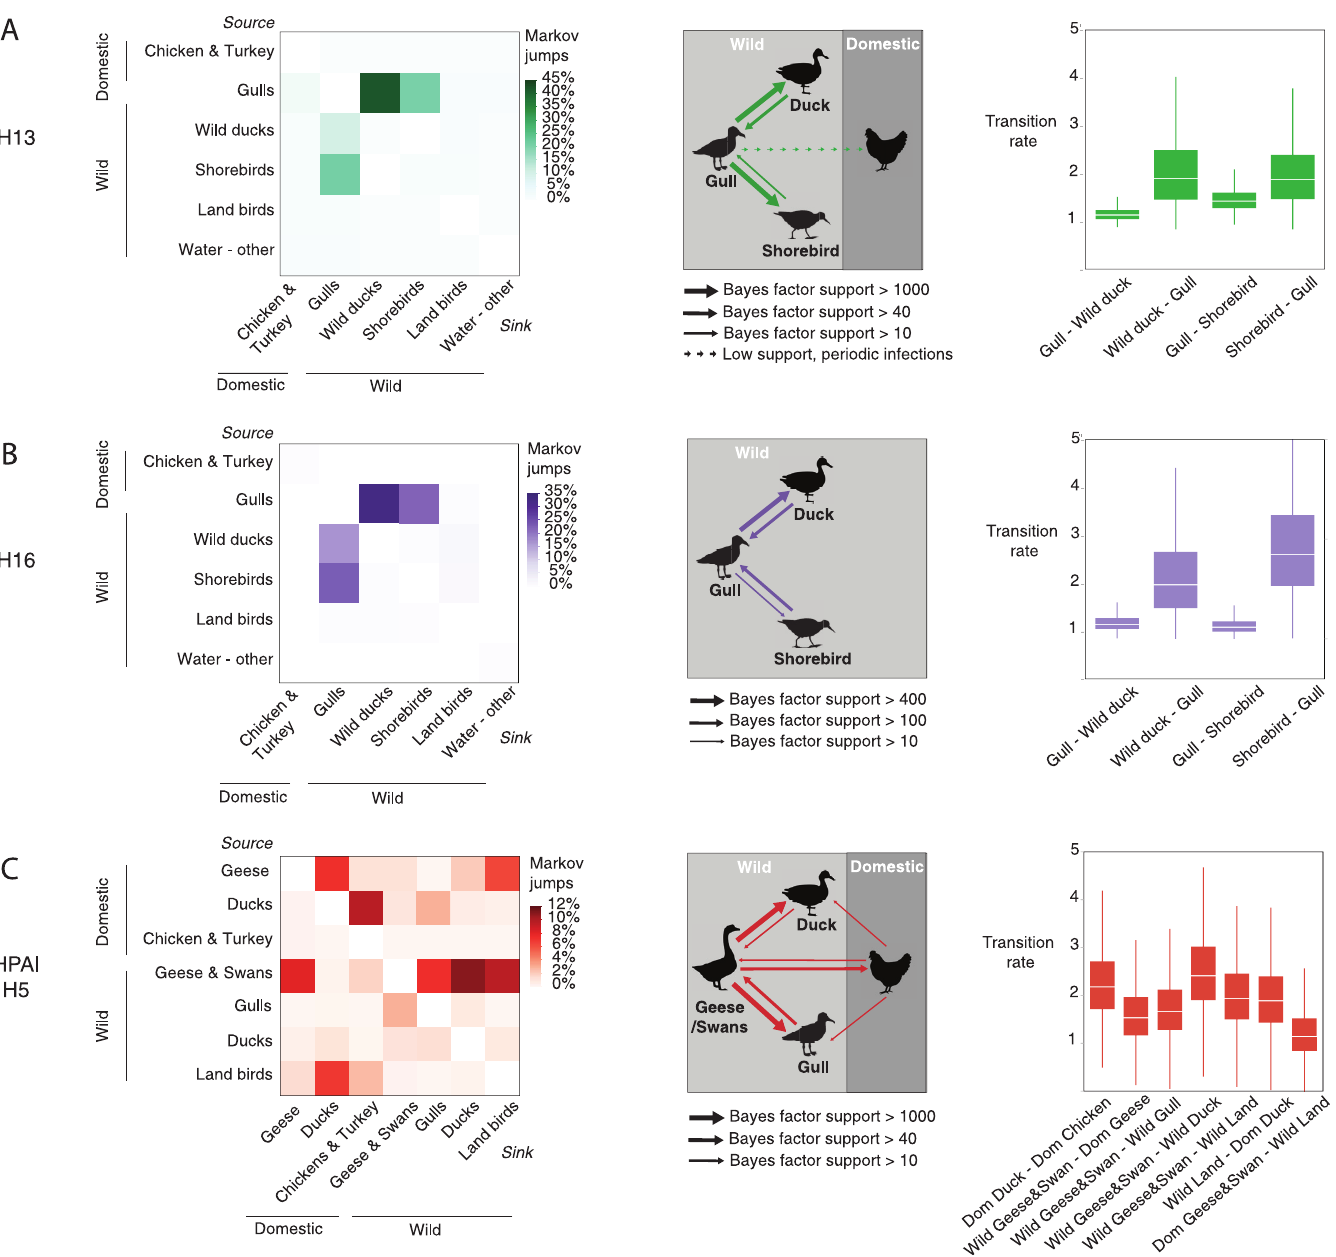
Fig 3. Host jumps and spillover of influenza A viral subtypes at the wild-domestic interface reflects co-evolution with the reservoir host. The heatmaps: A) H13 (green), B) H16 (purple) and C) HPAI H5 (red), indicate the frequency of transitions between host pairs estimated using a discrete trait phylogenetic model and the number of transitions between species/taxa was determined using Markov jumps. Host interfaces between wild and domestic birds (middle panel) are inferred based on host transitions that are well supported by Bayes Factors (BF). Dashed lines indicate known but infrequently sampled transmissions that could not be included in the analysis due to low sample size. Transition rates between host pairs are shown in the box and whisker plots (only the most strongly supported rates are shown). Large variation in transition rates is observed for HPAI H5N1 with highest rates between wild birds, followed by domestic poultry. In contrast, transition rates for H13 and H16 are lower with consistent patterns observed between host pairs for each subtype. Animal silhouettes from http://phylopic.org.